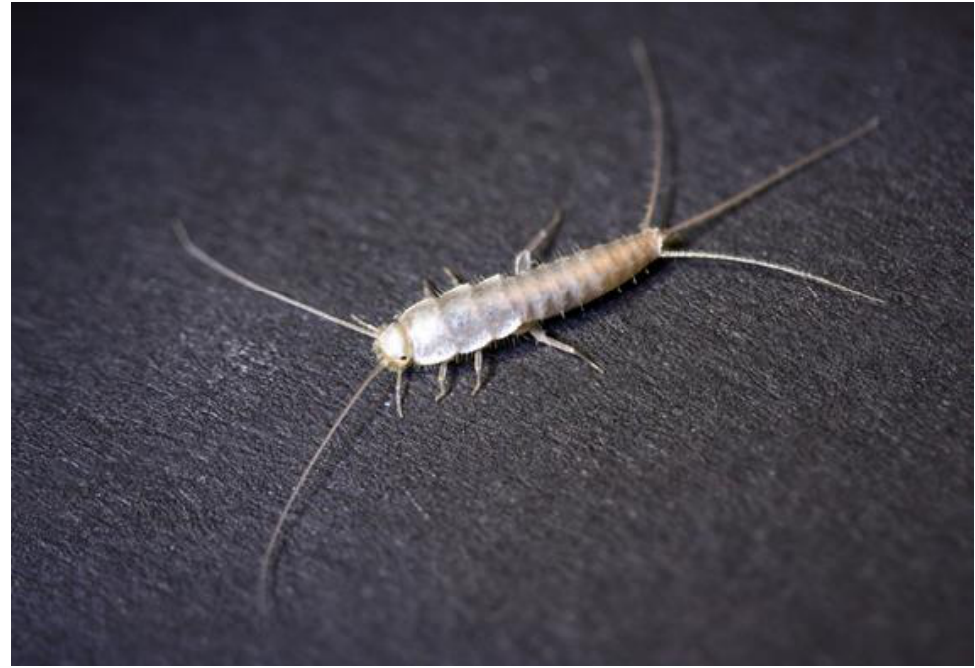
Figure 1. First image of Ctenolepisma calvum in Germany (Photograph: Sven Erlacher, Museum of Natural History Chemnitz).